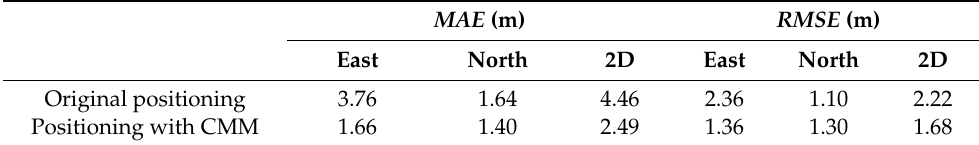
Table 5. The MAE and RMSE of dynamic positioning experimental results